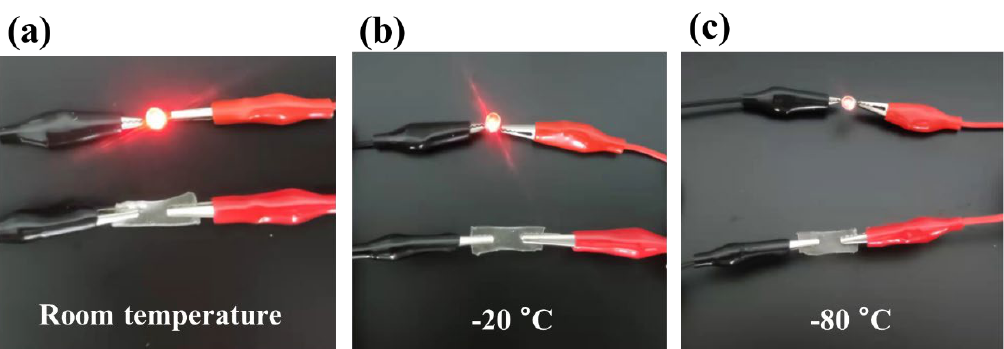
Figure 4. Conductivity of LiCl/p(HEAA − co − BD) hydrogel at different temperatures: ( a ) RT; ( b ) − 20 °C and; ( c ) − 80 °C.